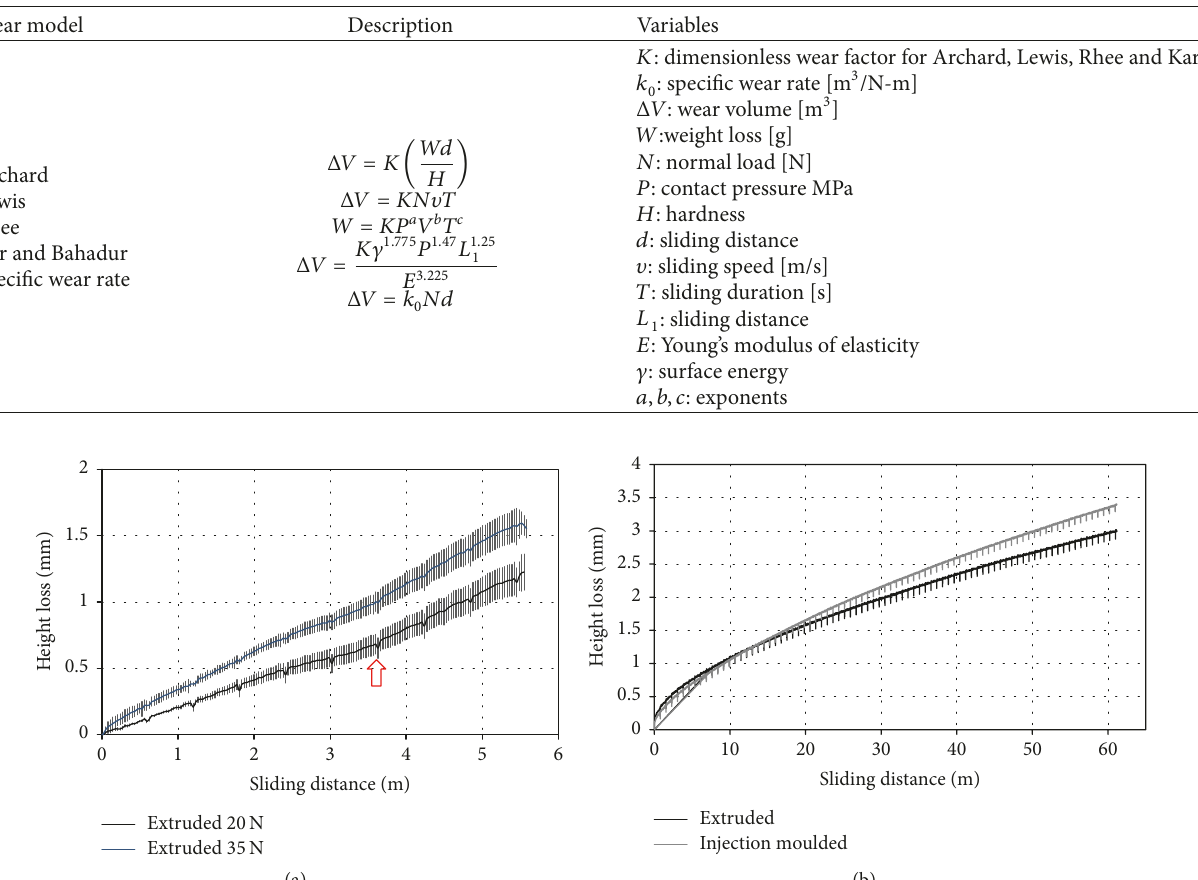
Table 3: Wear models for polymers.